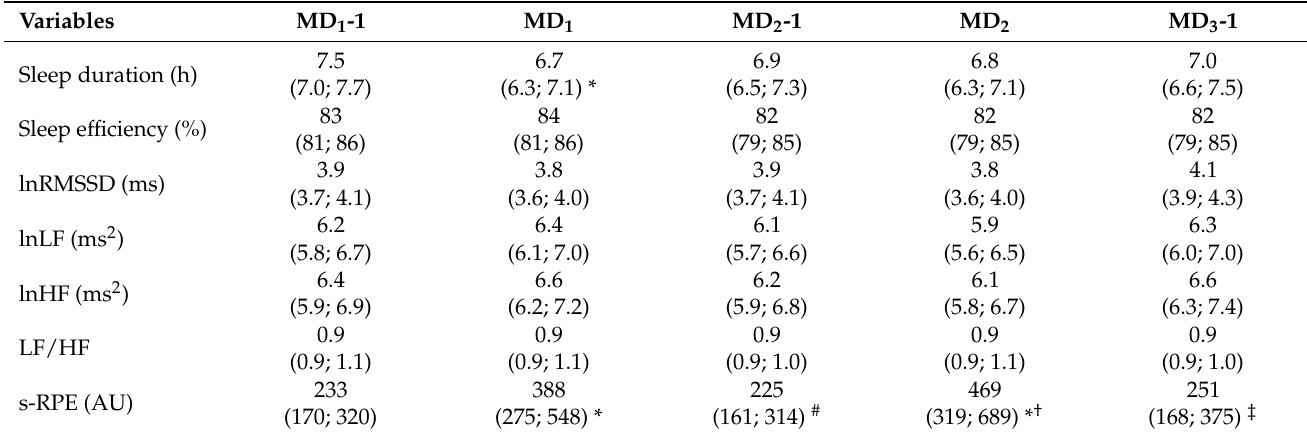
Table 1. Players’ actigraphy sleep characteristics, nocturnal cardiac autonomic activity, and session-rating of perceived exertion (s-RPE) during the 5 consecutive days of tournament.